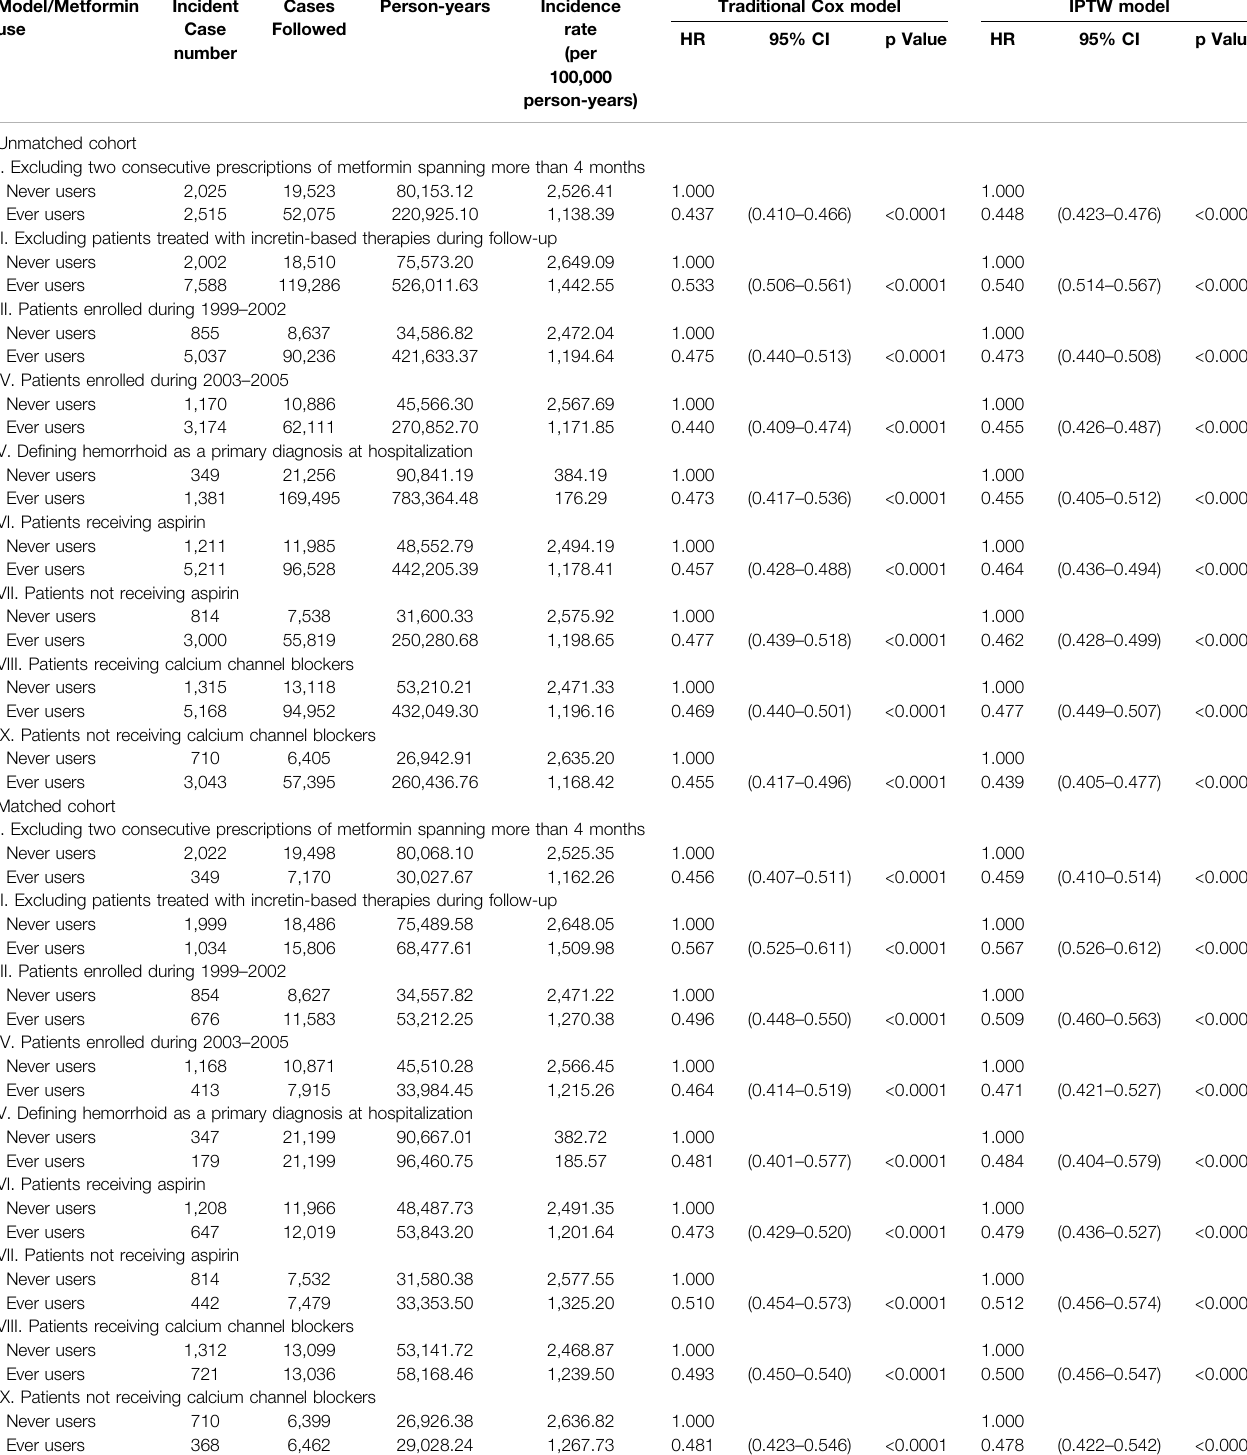
TABLE 3 | Sensitivity analyses for estimating hazard ratios for hemorrhoid by metformin exposure. Model/Metformin